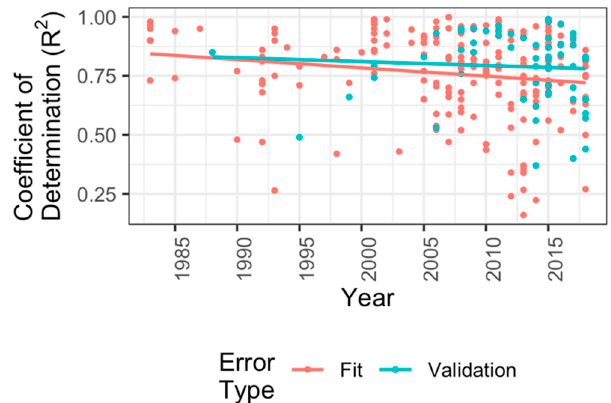
Figure 4. Reported R 2 values for model fit and model validation along with linear regressions of R 2 over time.